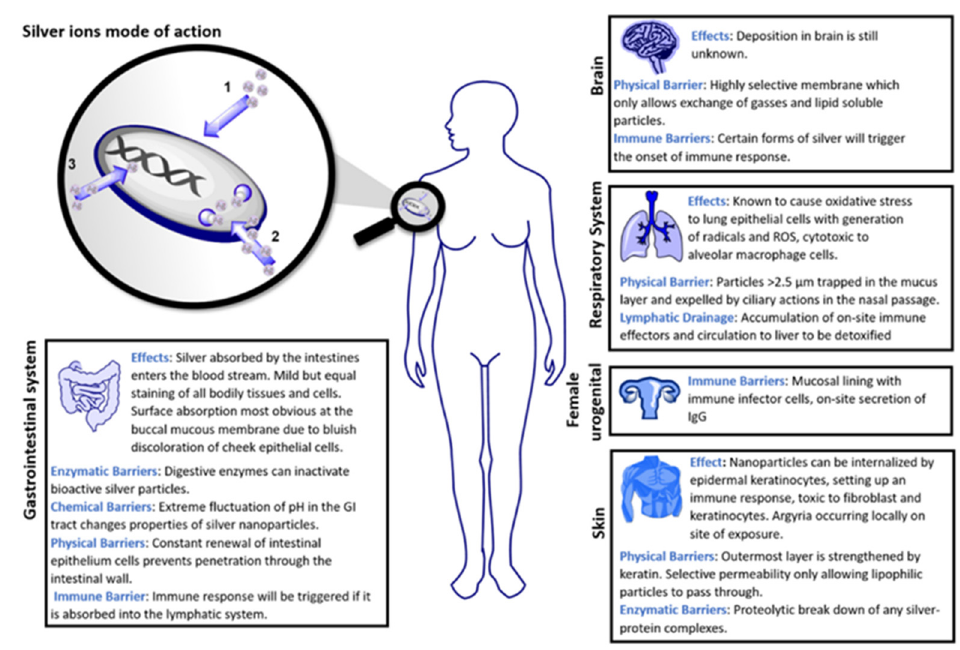
Figure 3. Mode of action of silver ions in the human body. Reprinted from Elsevier [73]. 2022, Karthik V